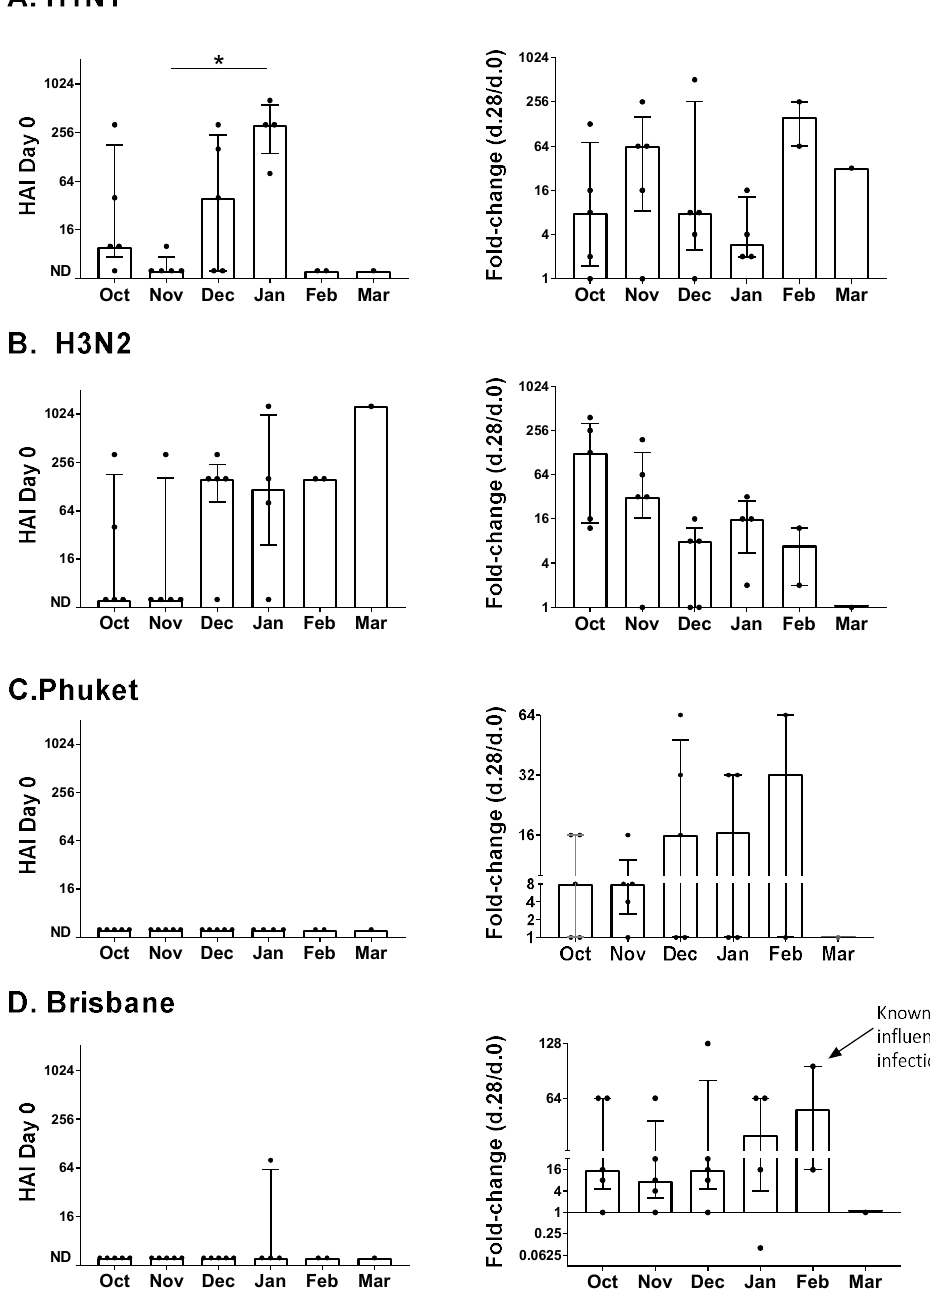
Figure 1. Hemagglutination inhibition (HAI) responses by month of vaccination in a pediatric influenza vaccine study. Participants ( n = 22) received the influenza virus vaccine during the 2016–2017 season. They were vaccinated in October ( n = 5), November ( n = 5), December ( n = 5), January ( n = 4), February ( n = 2), and March ( n = 1). Antibody titers were scored as the highest dilution that demonstrated HAI when replicates were identical or the average dilution when replicates were not identical. Negative scores (ND = not detected) were assigned a value of 5. Baseline (Day zero) HAI titers ( left ) and fold-changes in titers ( right , Day 28 compared to Day zero) are shown. Target viruses were ( A ). H1N1 (A/California/7/2009 H1N1). ( B ). H3N2 (A/Switzerland/9715293/2013 H3N2), ( C ). Phuket (B/Phuket/3073/2013), and ( D ). Brisbane (B/Brisbane/60/2008). Data were cate- gorized by the month of vaccination with medians and interquartile ranges. Each symbol (dot) represents a different individual. Significant differences between months were determined by the Kruskal–Wallis test with the Dunn’s multiple comparisons test. Statistical significance is indicated with an asterisk (* p < 0.05). Baseline serum HAI titers (Day zero, Figure 1, left column) and changes post-vaccination (Day 28 compared to Day zero, Figure 1, right column) are shown for each of the vaccine com- ponents. HAI titers toward H1N1 and H3N2 viruses were often detectable at baseline (12/22 and 13/22 positive responses, respectively, at baseline), whereas HAI titers toward Phuket and Brisbane viruses were rarely detectable at baseline (0/22 and 1/22 positive responses, respec- tively, at baseline). This may reflect the frequent circulation of type A influenza viruses and the likelihood that study participants were exposed prior to study enrollment.